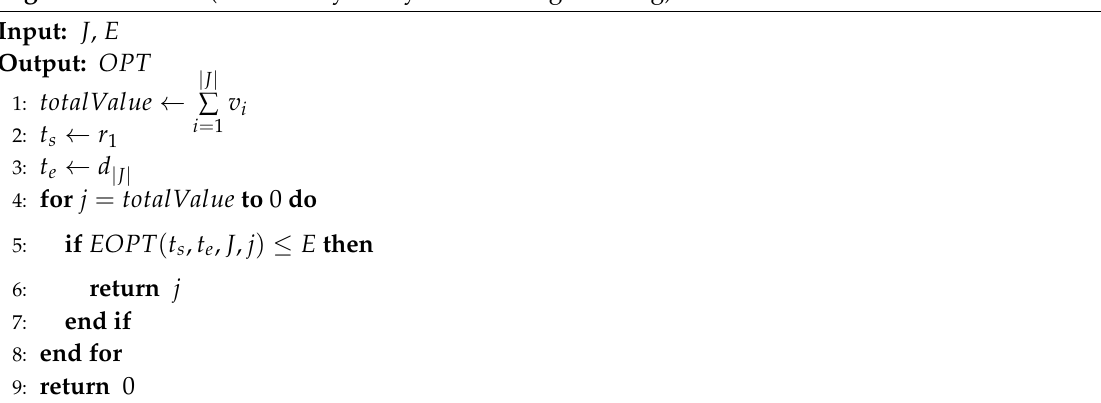
Algorithm 3 DLDP(Double Layers Dynamical